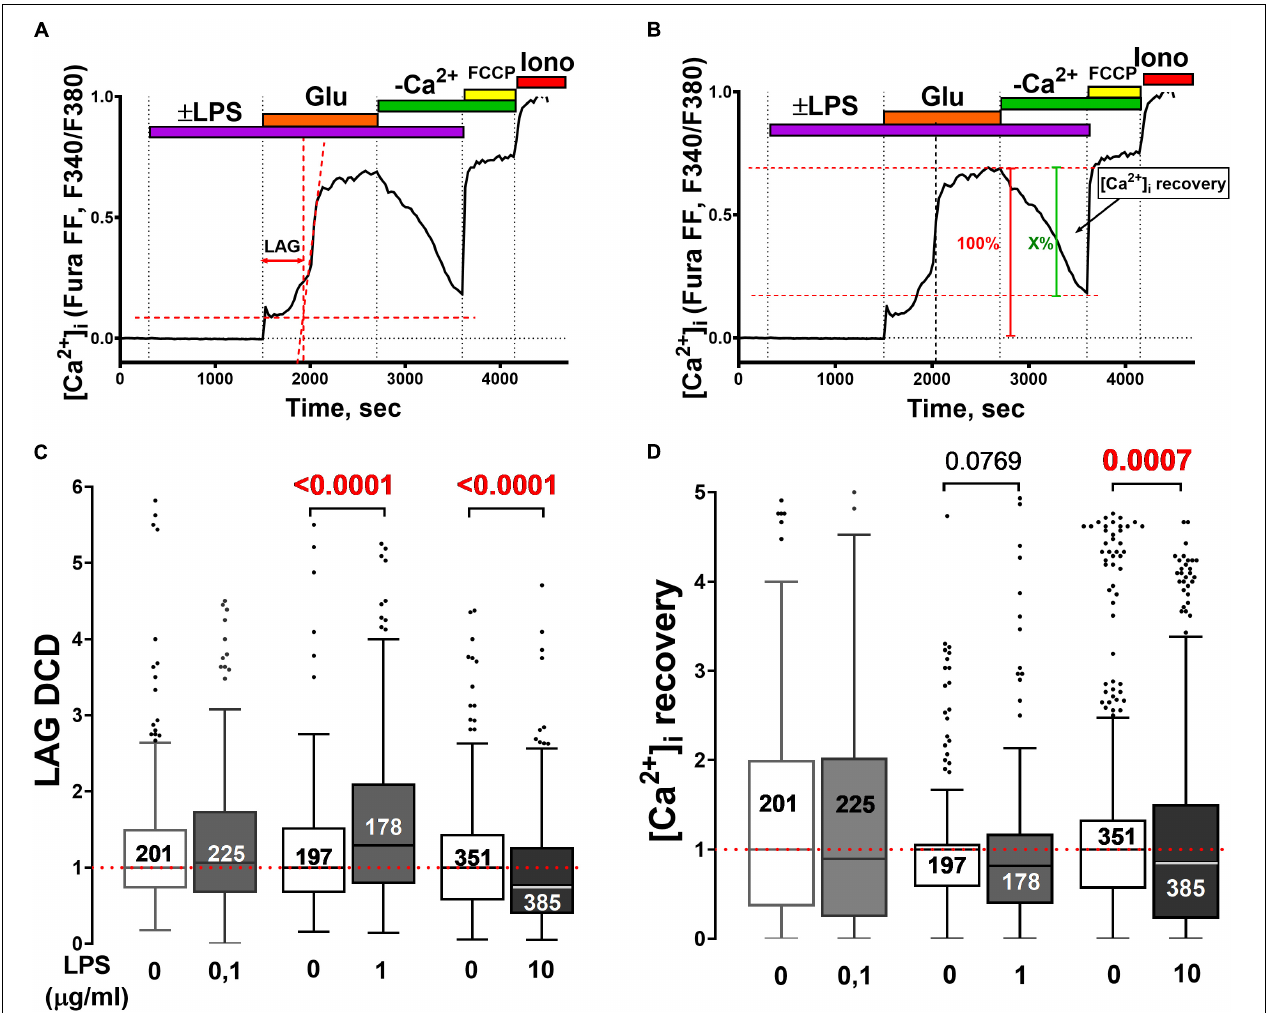
FIGURE 2 | Effect of LPS on the development of glutamate-induced delayed calcium deregulation and post-glutamate [Ca 2 + ] i recovery in neuronal cultures from the rat cortex. (A) Changes in [Ca 2 + ] i in a representative neuron to illustrate the method used to determine the lag-period of delayed calcium deregulation (lag-DCD, s). The onset of DCD is considered to be the intersection of the tangents (red dotted lines) to the [Ca 2 + ] i curve during the first phase of the cellular response to Glu (33 µ M) and the secondary rise of [Ca 2 + ] i . The lag-DCD is the time from the Glu addition to the onset of DCD. (B) Illustration of a method for quantifying [Ca 2 + ] i recovery (X,%) after Glu washout. (C) Turkey box-plot histogram of lag-DCD (s) during Glu challenge and (D) [Ca 2 + ] i recovery (X,%) during Glu washout in the presence of different LPS concentrations. Numbers on histogram bars indicate the amount of neurons that developed DCD; 5–8 experiments for each LPS concentration and control experiments in sister cultures. LPS concentrations ( µ g/ml) are given beneath the bars. Statistically significant differences were determined according to the Mann-Whitney